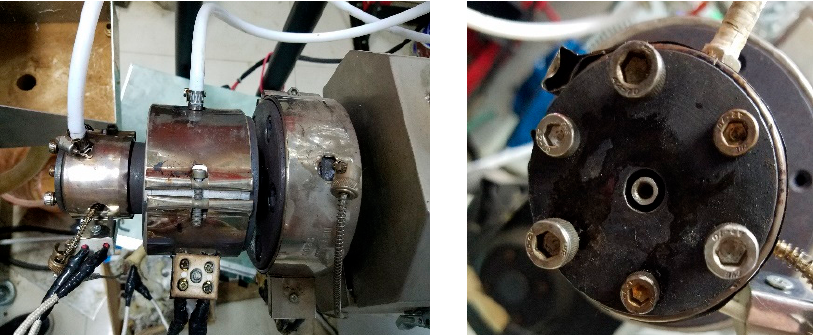
Figure 2. Double-layer gas-assisted extrusion die. The left one is physical assembly picture of the die, the right one is physical picture at the die exit.